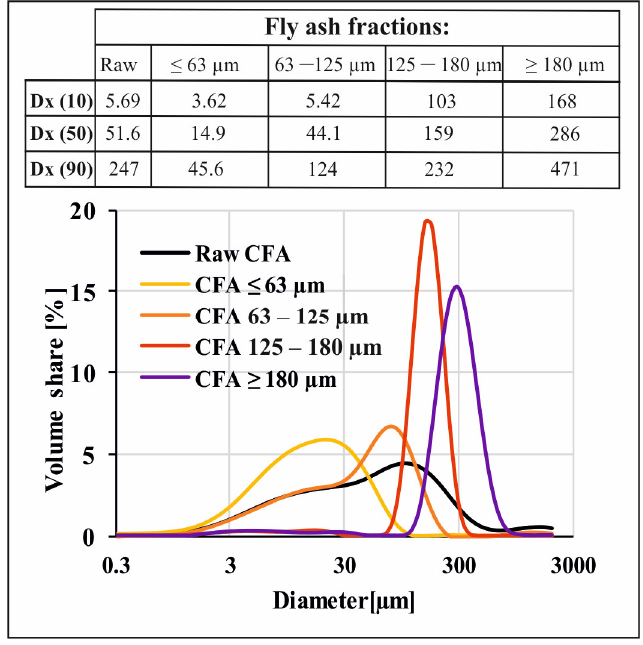
Figure 5. Particle size analyses of raw fly ash and fly ash fractions after sieving.